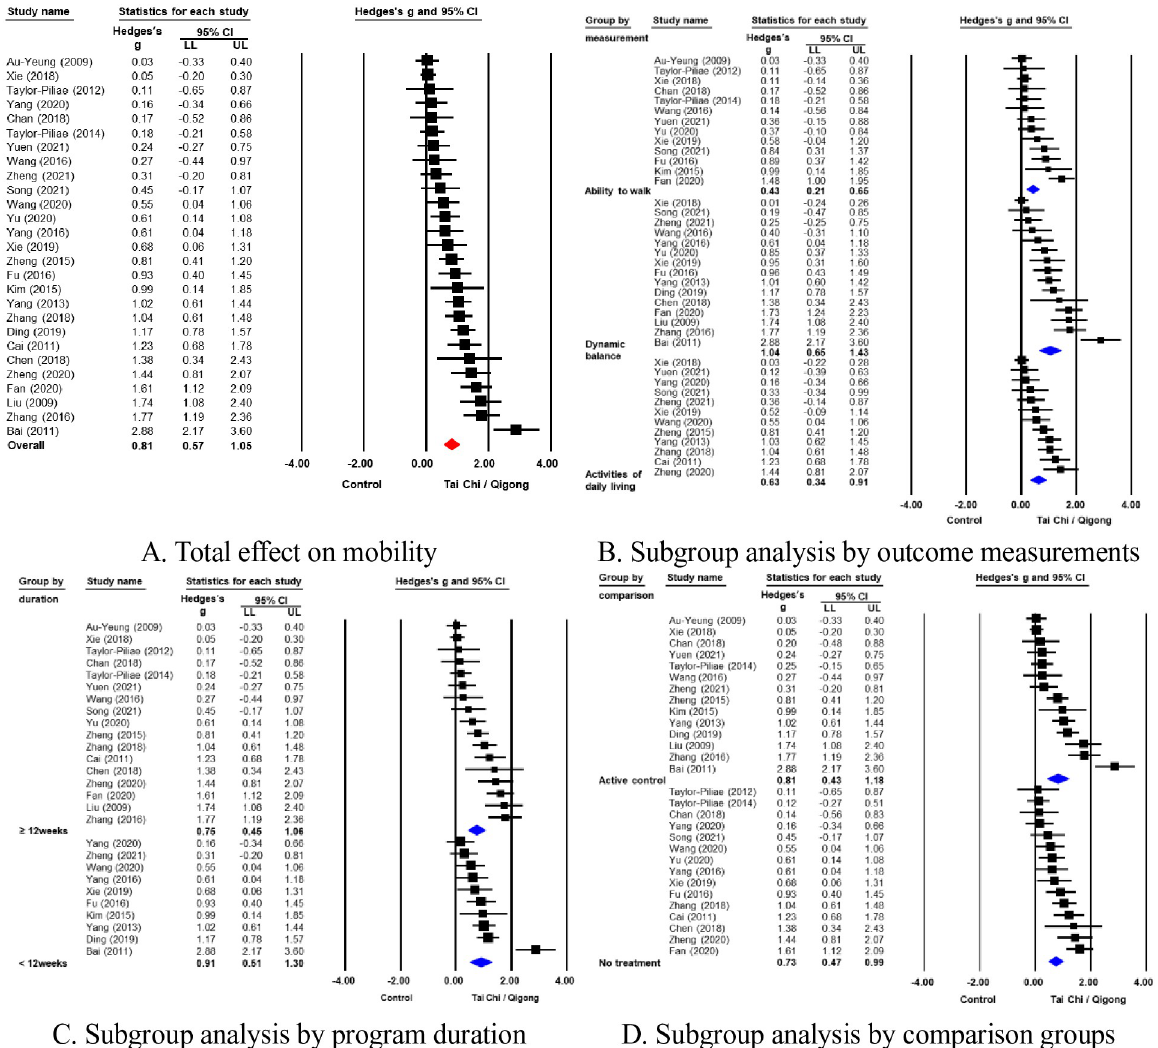
Fig 3. Forest plots of the effects of Tai Chi and Qigong on